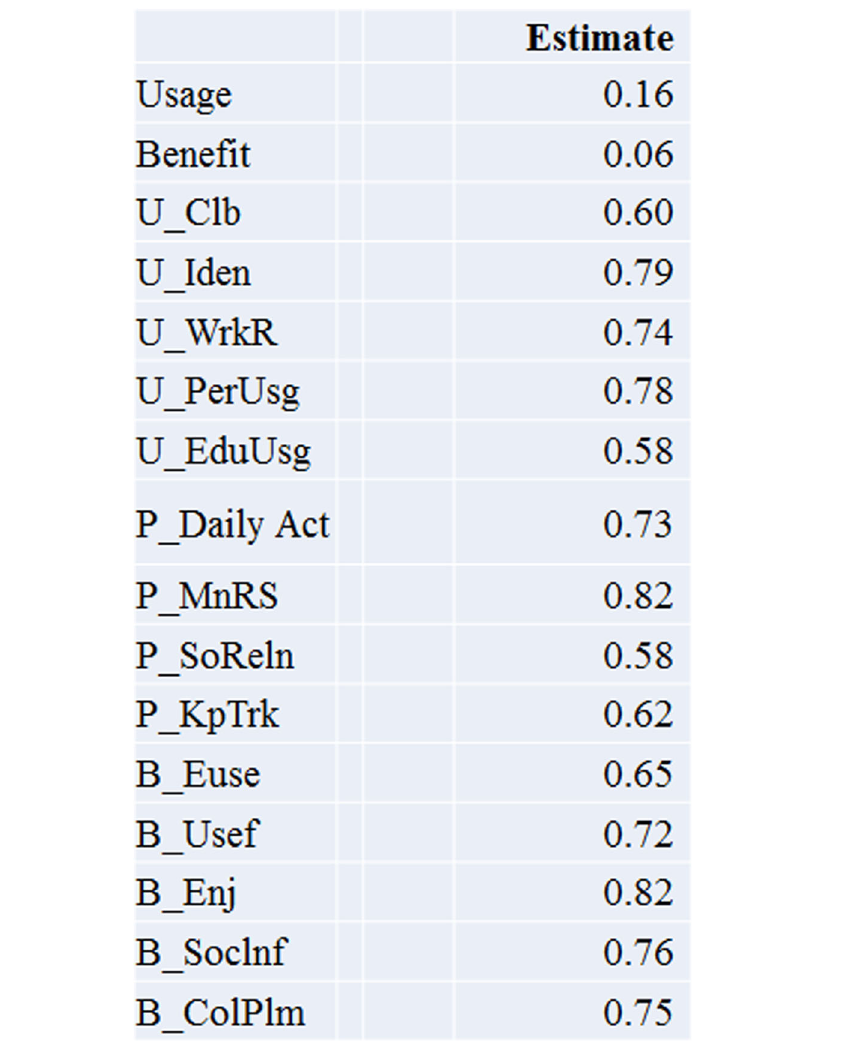
Table 6 Squared Multiple Correlations (R 2